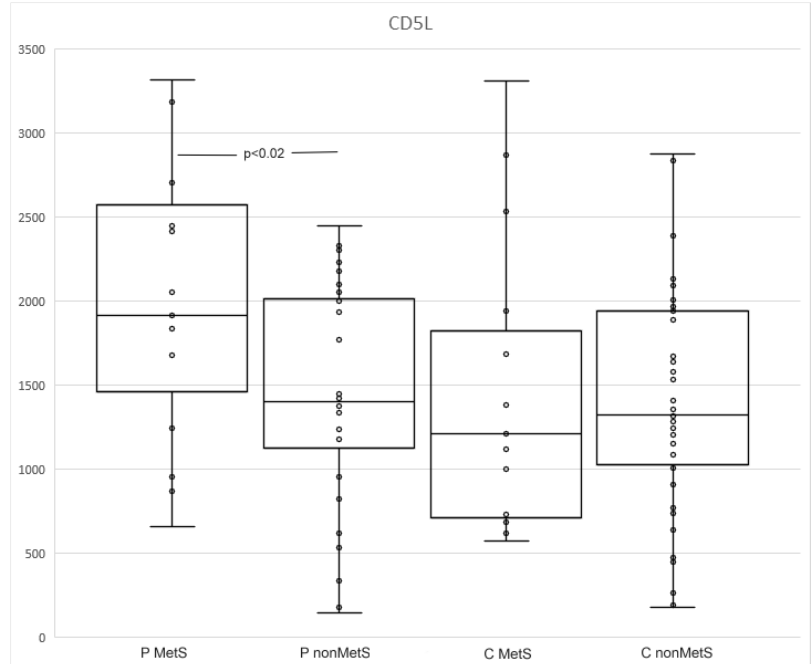
Figure 3. The levels of CD5L in MetS and nonMets patients and controls.